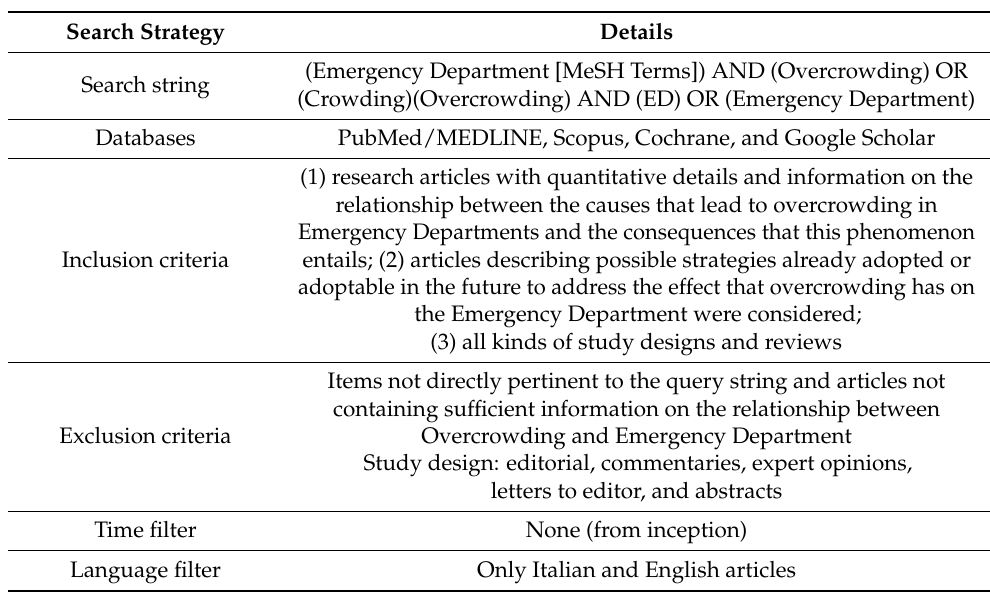
Table 1. Search strategy.